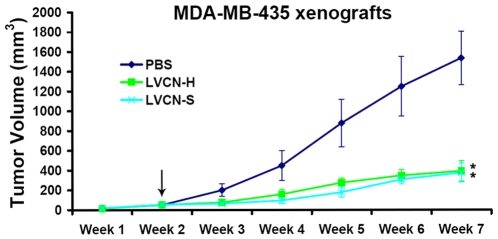
The initial evaluation of liposomal formulations of VCN in the MDA-MB-435 xenograft model.Nude mice were inoculated orthotopically (mammary fat pads; 5×105 MDA-MB-435 cells in complete Matrigel per mouse) and tumors allowed to grow until they became palpable before the treatments were initiated (indicated by the arrow). The animals (n = 5) were treated twice a week with liposomal formulations of VCN that were prepared either by sonication (LVCN-S) or homogenization (LVCN-H). The latter method of encapsulation is suitable for scale-up production and was done in a microfluidizer. All LVCN-treated animals received the dose-equivalent of 100 µg of VCN per injection and were compared to a control group that received saline only. All treatments were administered intravenously twice a week via tail vein. The statistical analysis was done using ANOVA with Dunnett's post-hoc multiple comparison tests (* signifies a P<0.001). The liposomal formulations tested showed comparable efficacies. This animal model was repeated three times.